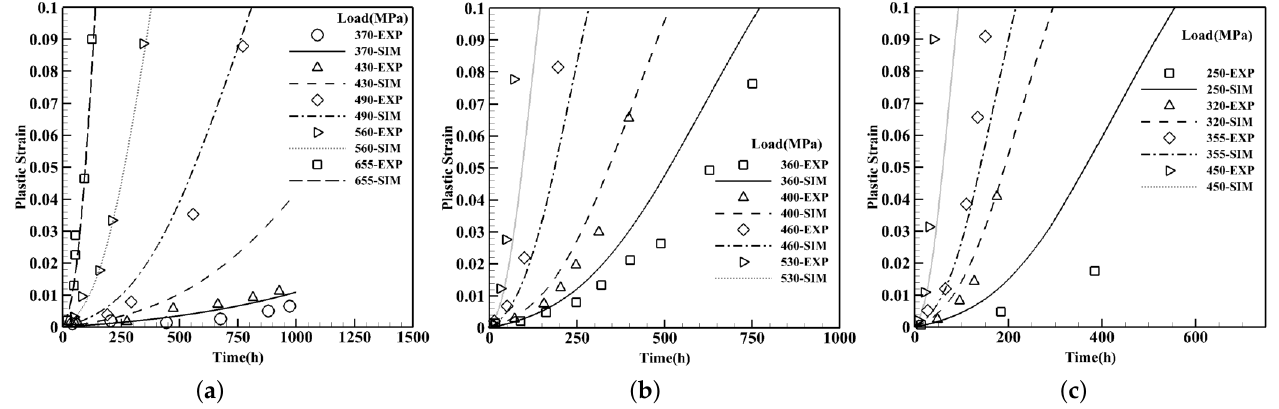
Figure 8. Creep curves of single-crystals of CMSX-4 at different temperatures compared with the experimental data [42] at ( a ) 850 ◦ C , ( b ) 900 ◦ C , and ( c ) 950 ◦ C .